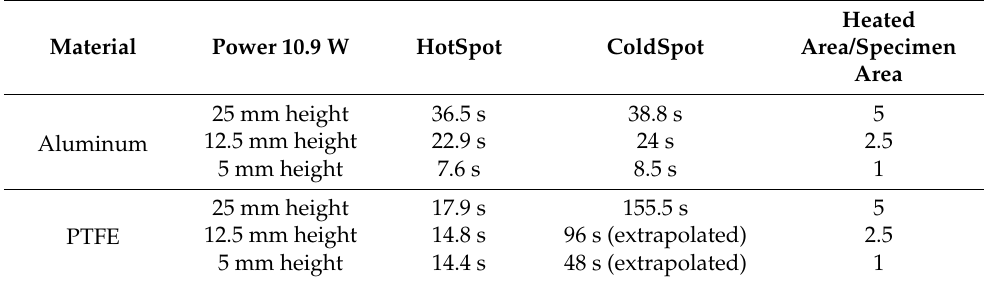
Table 4. Time elapsed to reach 5 ◦ C at HS and CS of various samples.